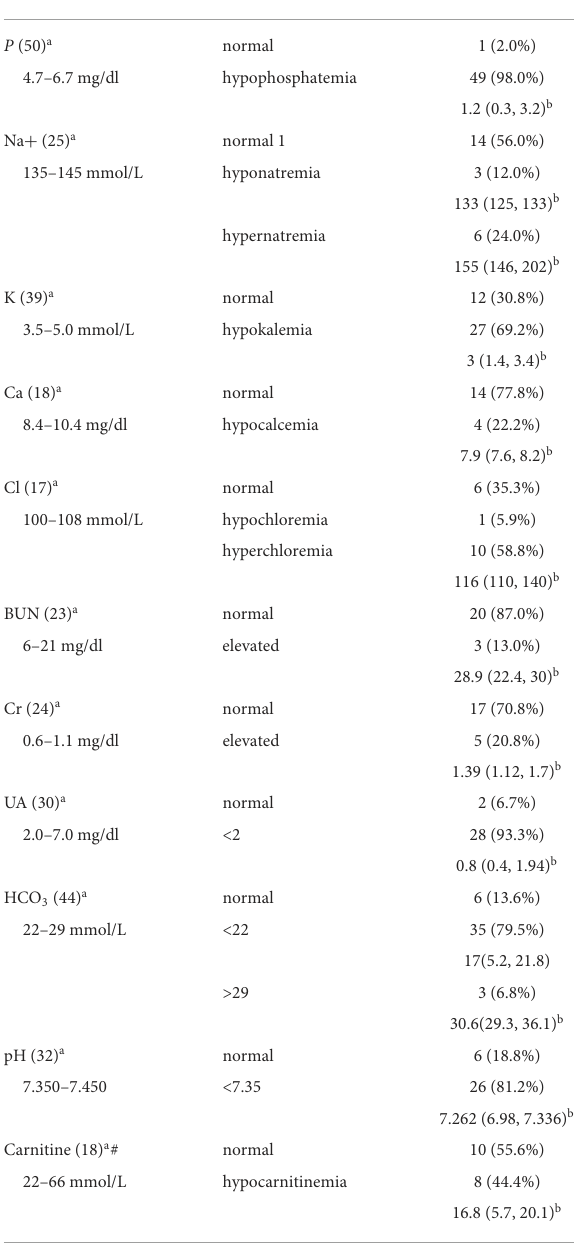
TABLE 3 Serum biochemical analysis of 54 patients